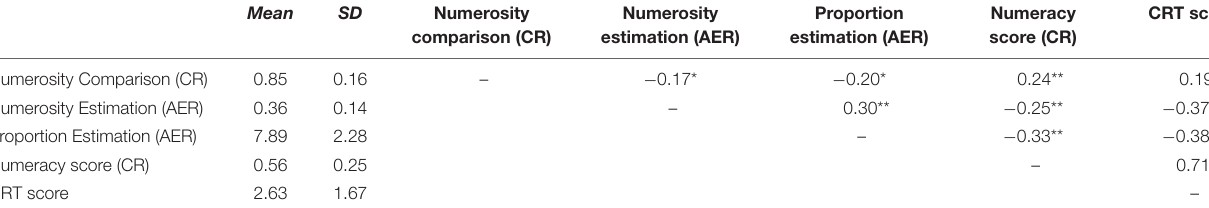
TABLE 1 | Bivariate correlations between numerosity discrimination, estimation, proportion estimation, numeracy and CRT.